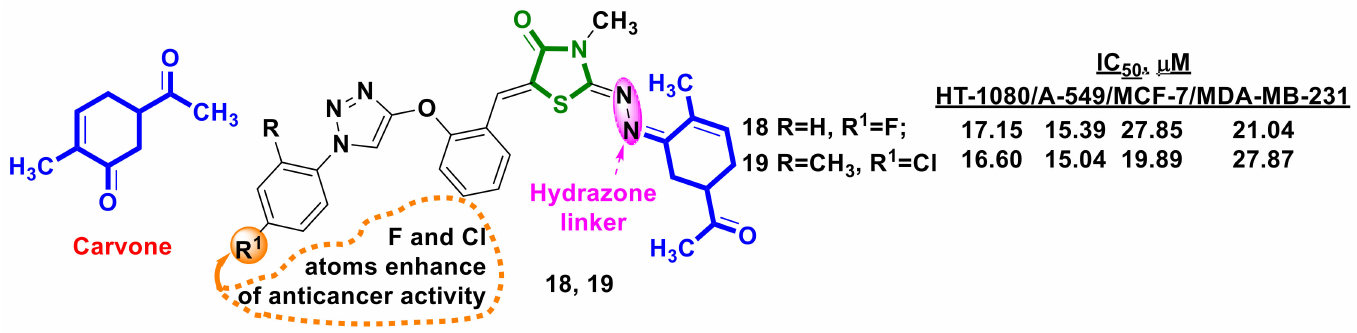
Figure 8. Structures of 4-thiazolidinone hybrids with